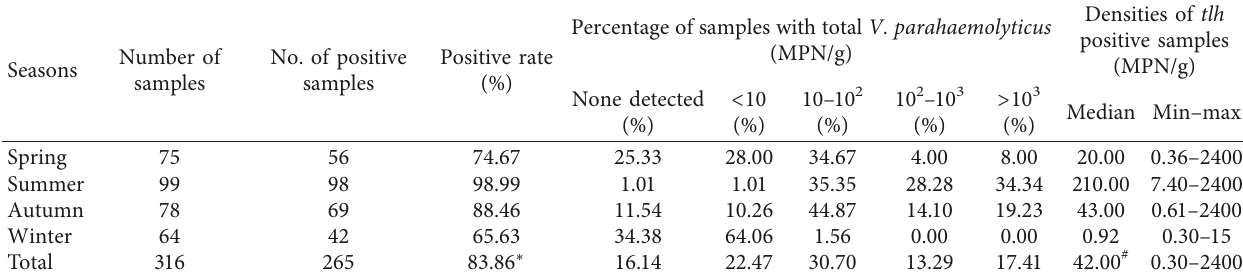
Table 3: Contamination levels of total Vibrio parahaemolyticus in Anadara subcrenata in different seasons.